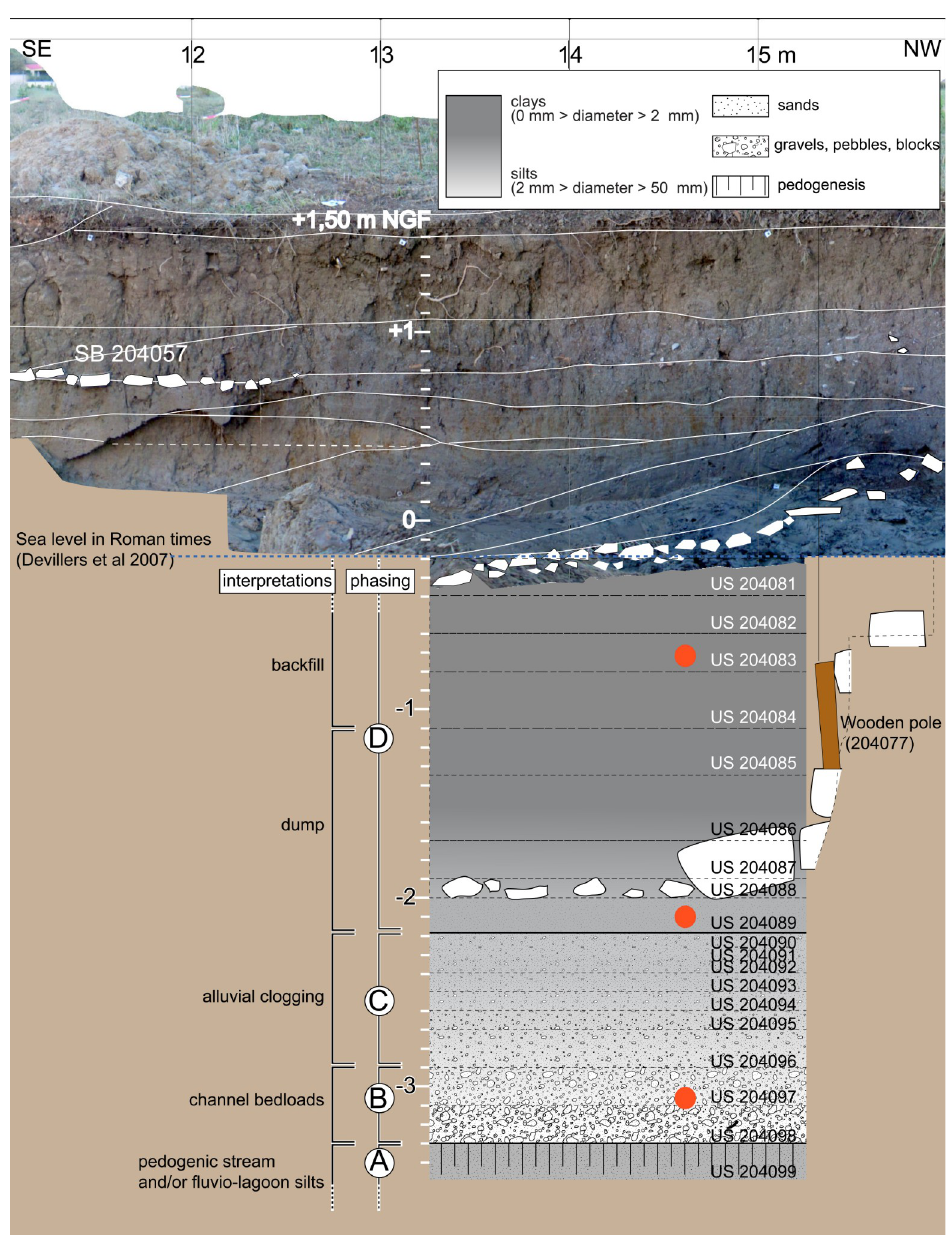
Fig 6. Stratigraphy of the samples that were studied in 2016. (M. Tillier) in zone 204 (in red) and compared here with MAS.